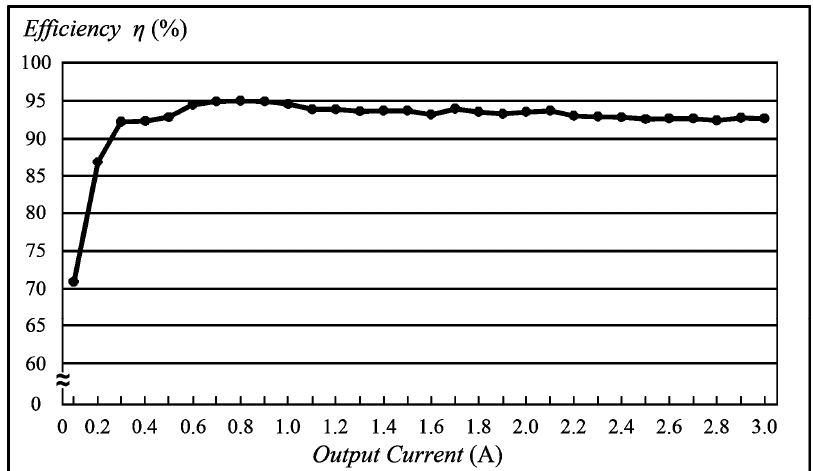
Figure 14. The overall efficiencies of the battery power bank.